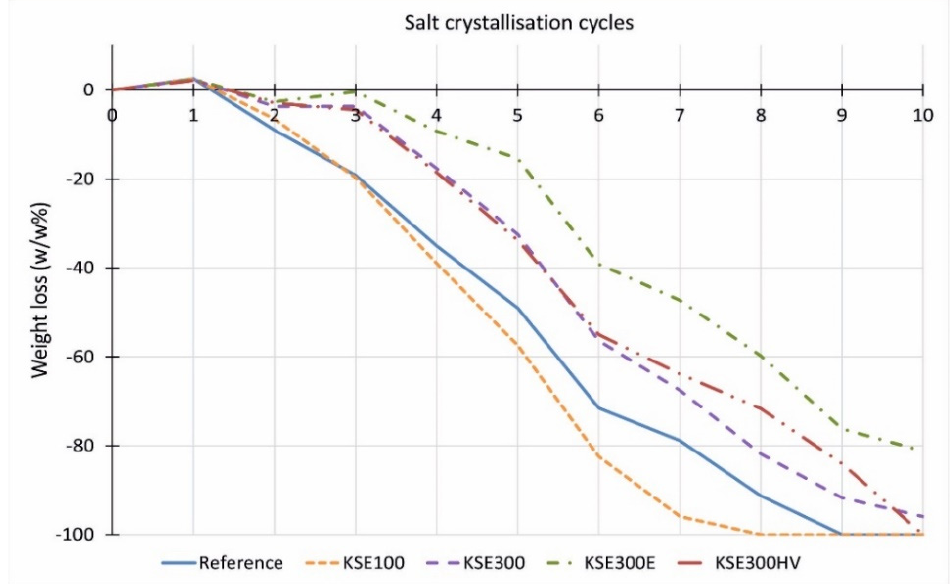
Figure 15. Weight loss of fine-grained porous limestone from Sóskút (SF) after salt crystallization cycles.